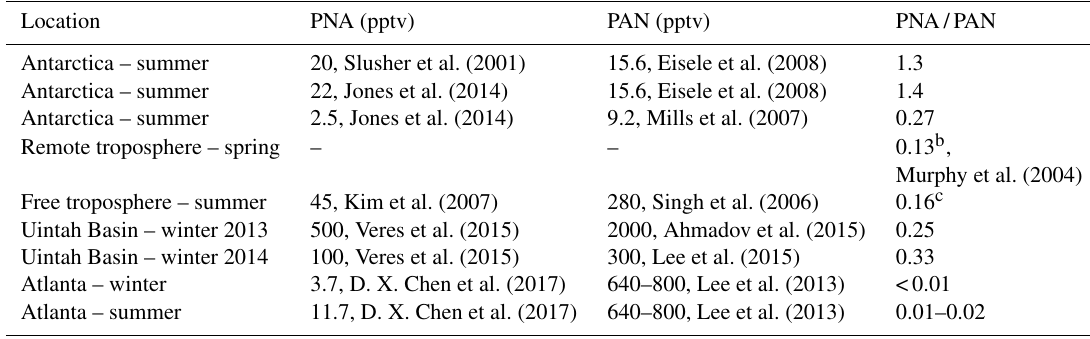
Table 1. Typical a PNA and PAN mixing ratios in various environments where both were quantified. Location